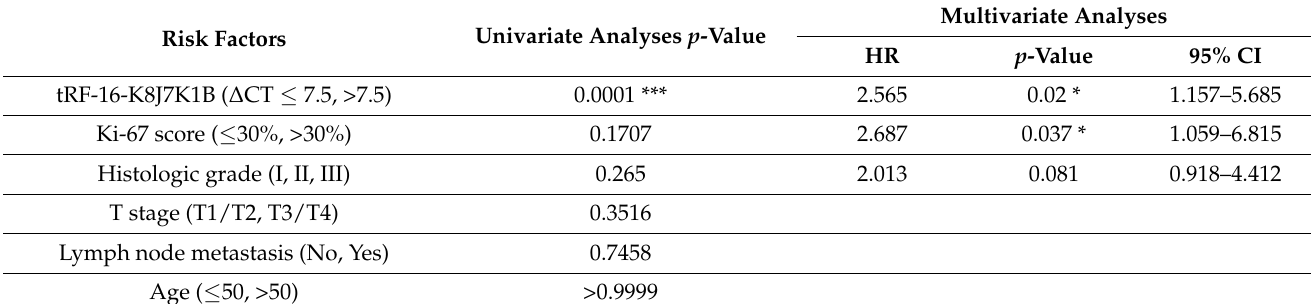
Table 1. Univariate and multivariate analyses of the clinicopathological factors for PFS in HR+ breast cancer. * p < 0.05; *** p <